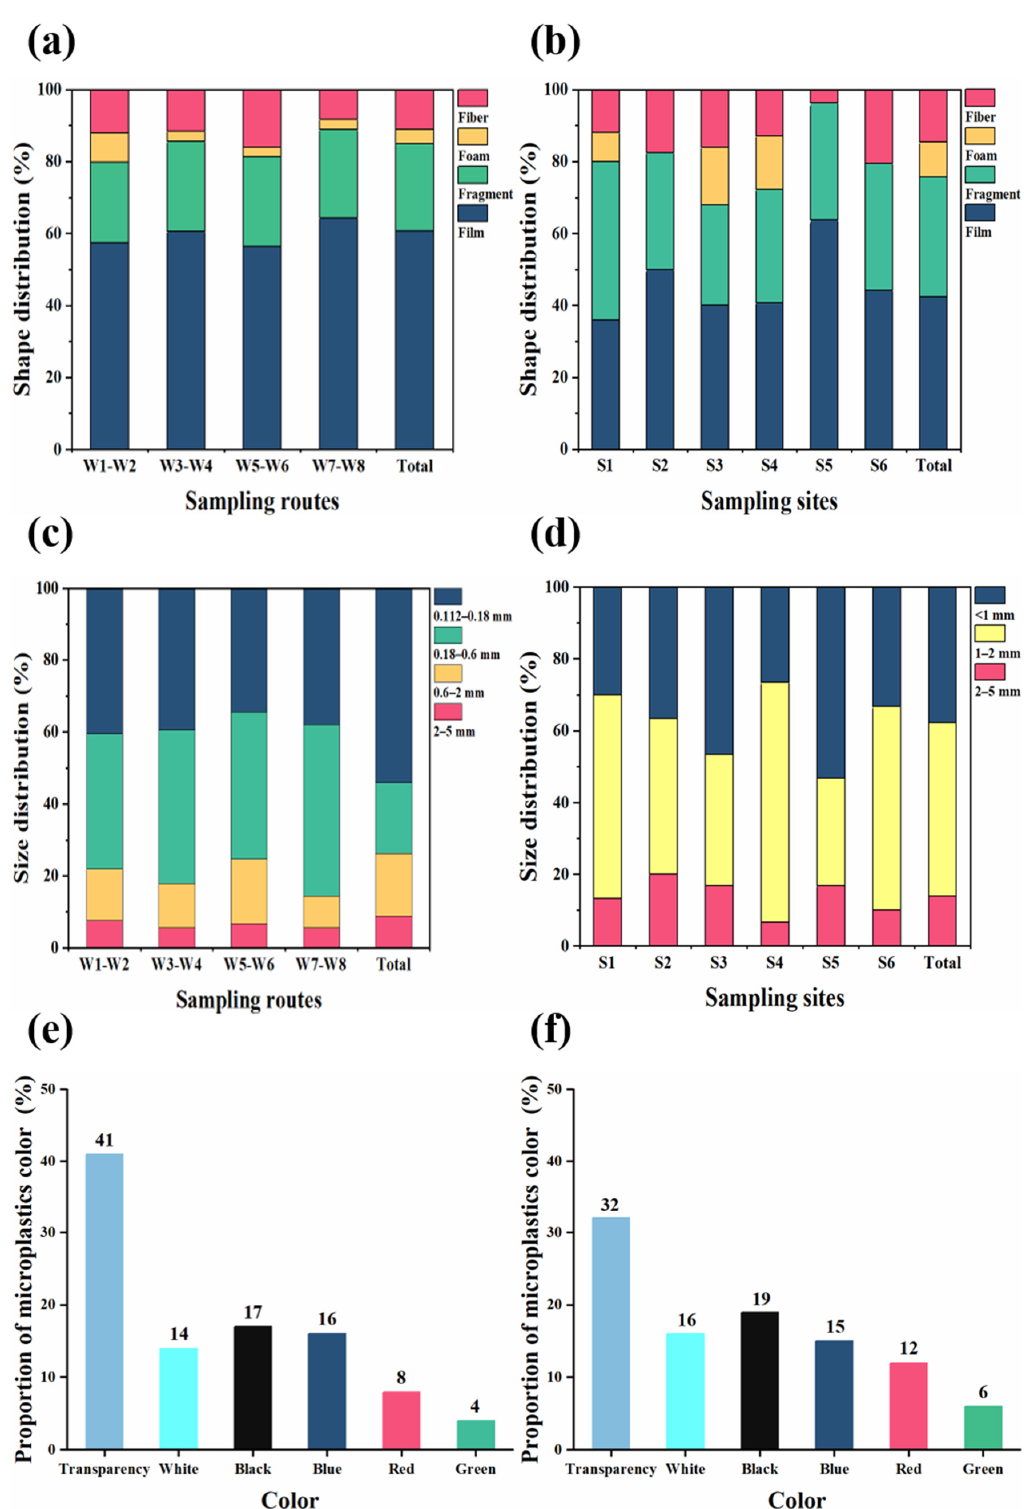
Figure 5. In surface water ( a ) and in surface sediments ( b ) of Songshan Lake, the relative proportions of different morphological shapes of microplastics were determined. Size distribution of microplastics in the surface water ( c ) and the surface sediments ( d ) of Songshan Lake. The proportion of microplastic color in the surface water ( e ) and surface sediment ( f ) of Songshan Lake.